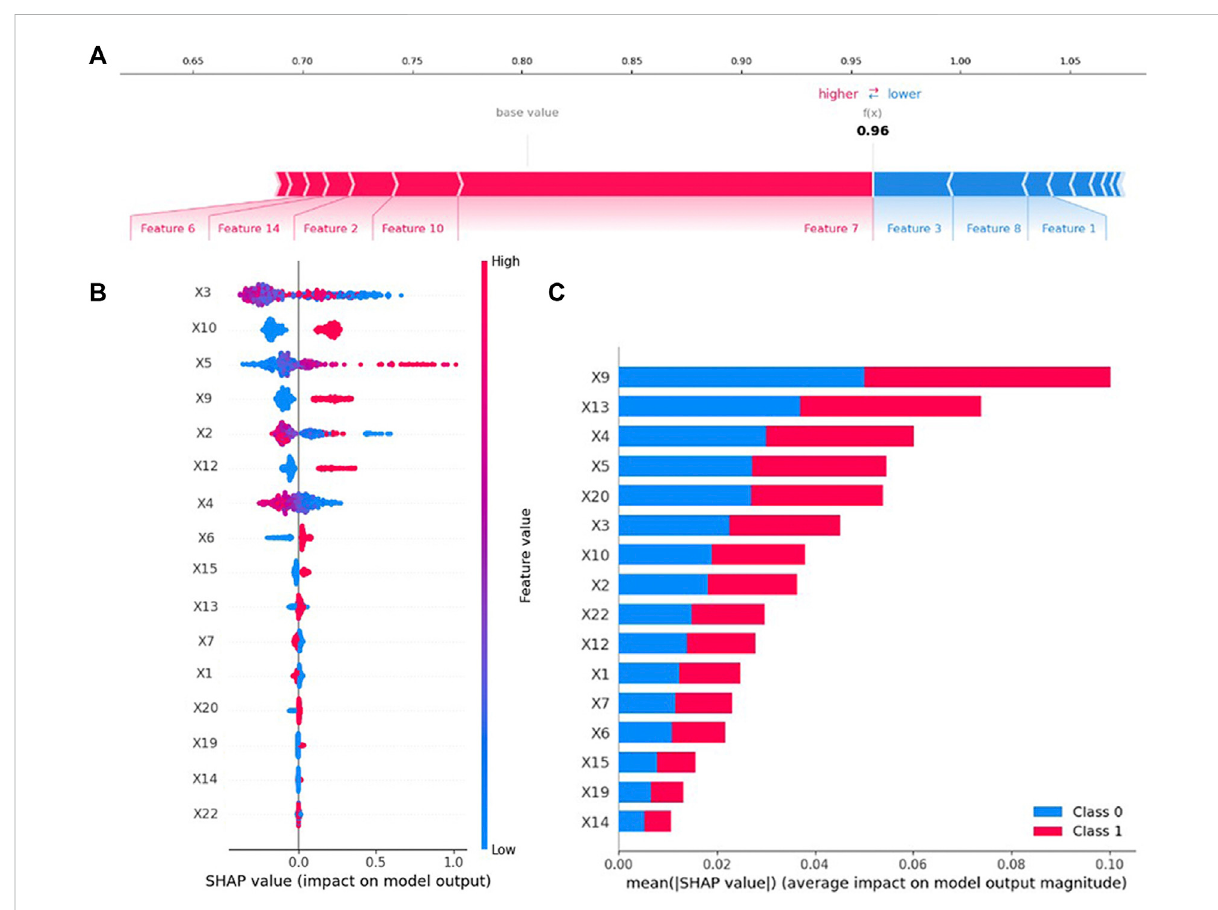
FIGURE 4 Variablecontribution tothePIPmodelbySHAPValue. (A) Contributionofeachfeaturevalueinonesample. (B) SummaryofSHAPvalueofeach variable. (C) Absolute average of SHAP value of each